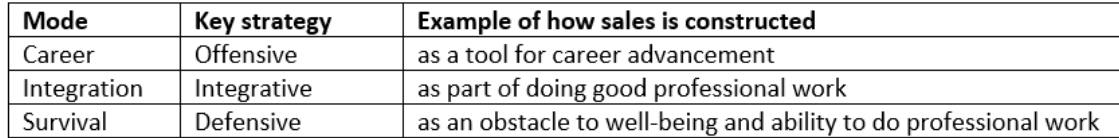
Table 1. Three modes of strategic